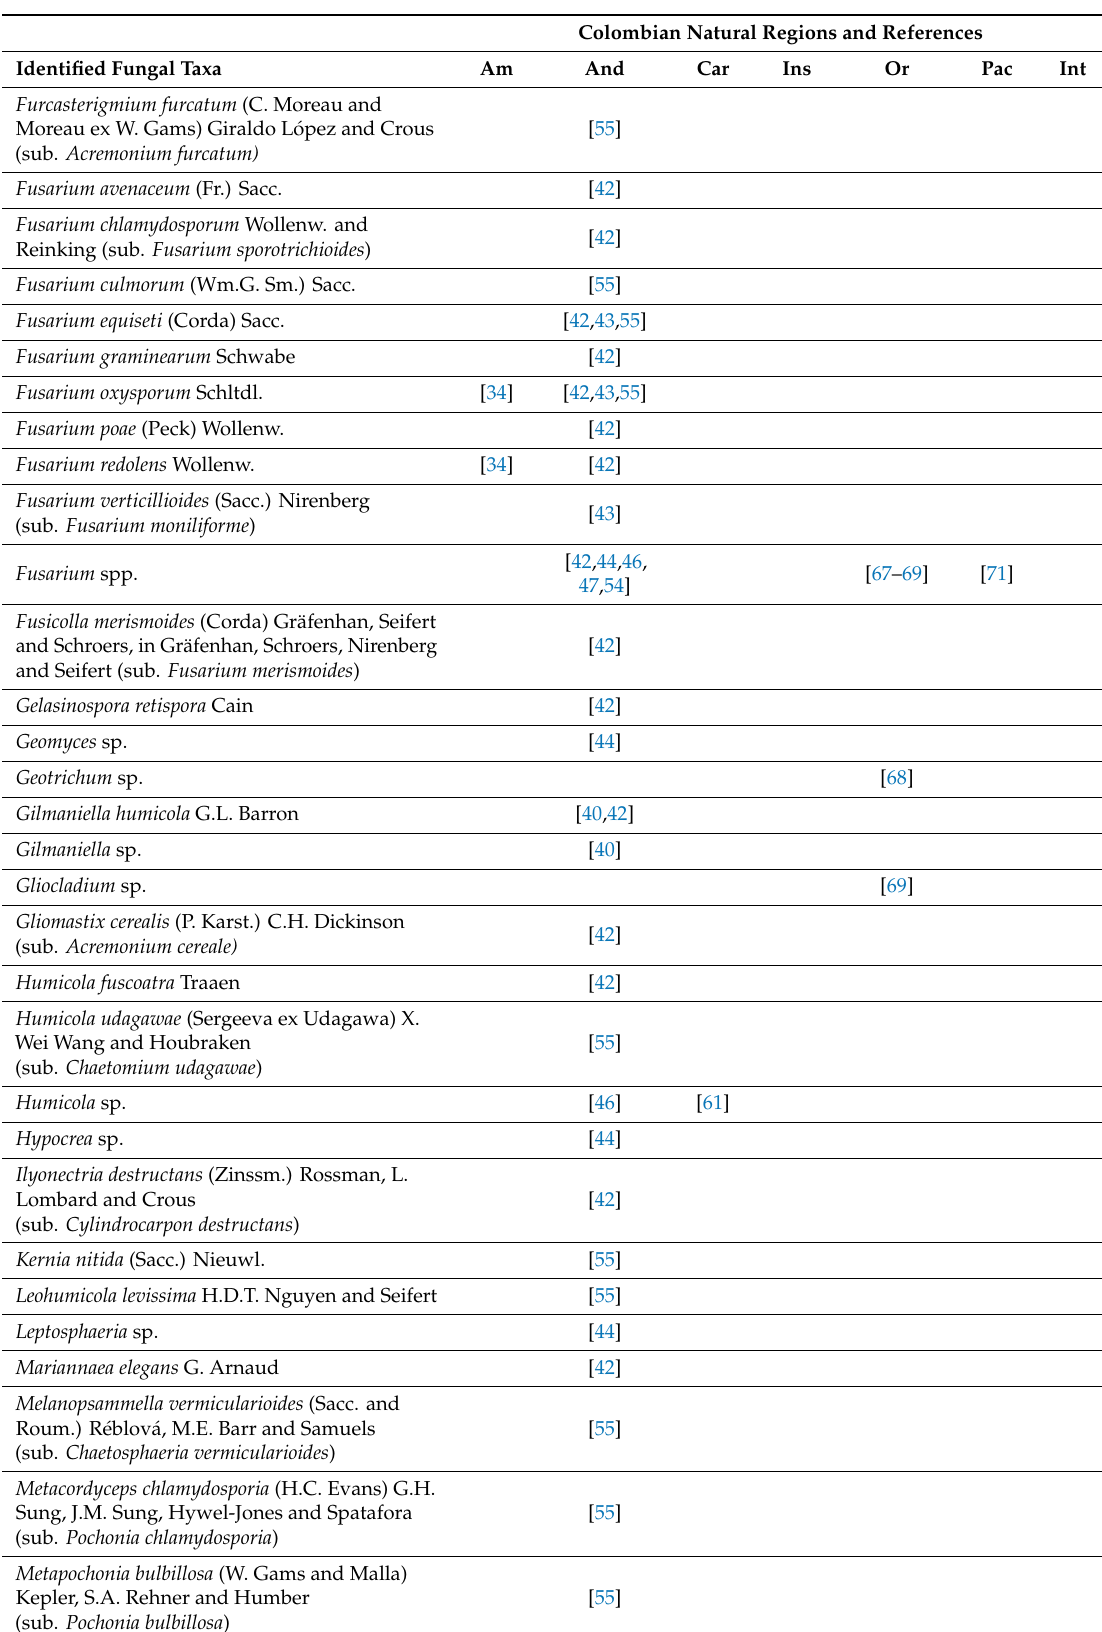
Table 1. Cont . Colombian Natural Regions and